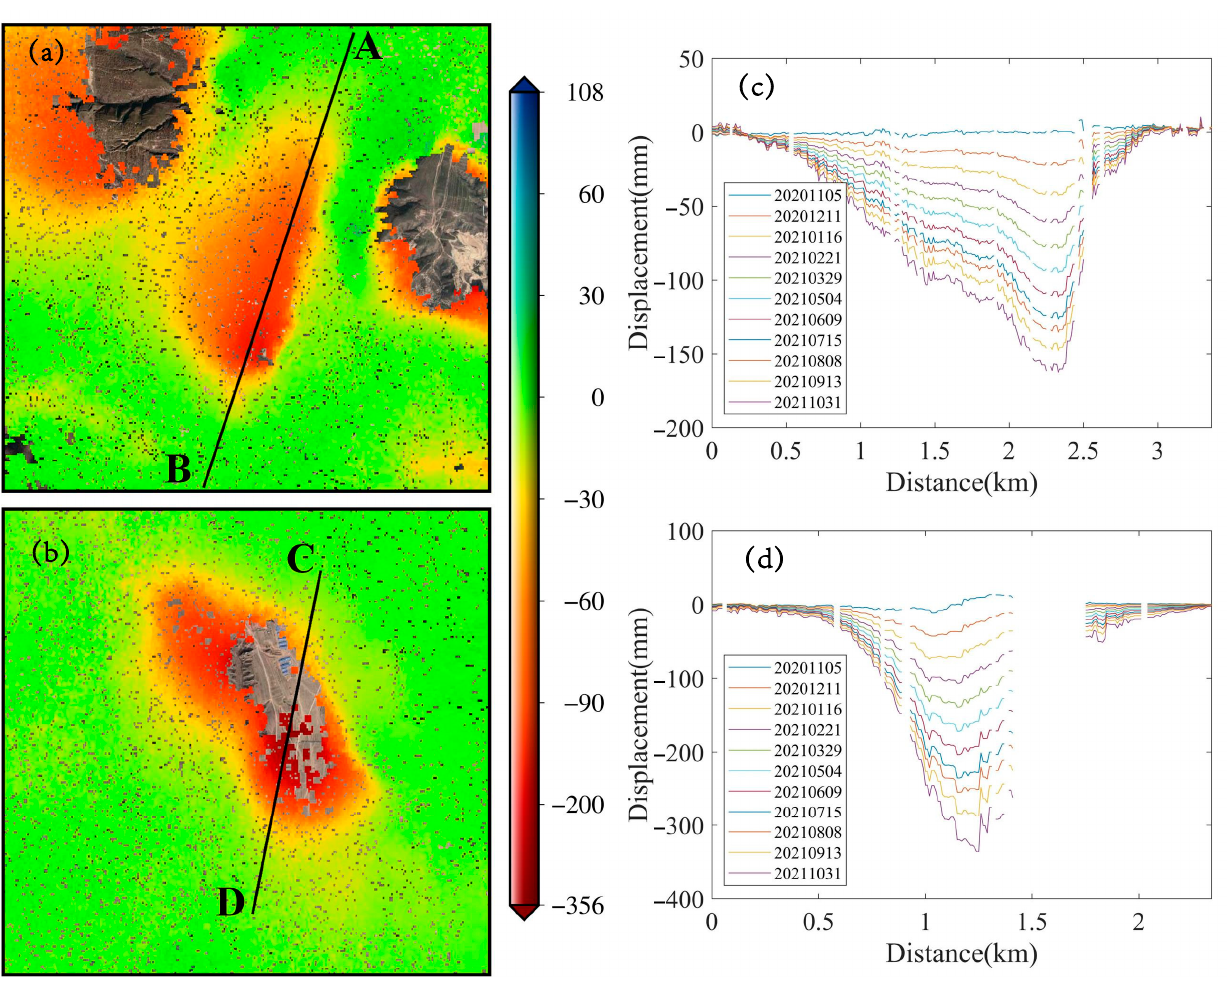
Figure 13. Images ( a , b ) are the local cumulative deformation from 5 November 2020, to 31 October 2021; ( c , d ) are the cumulative time-series displacement on section lines AB and